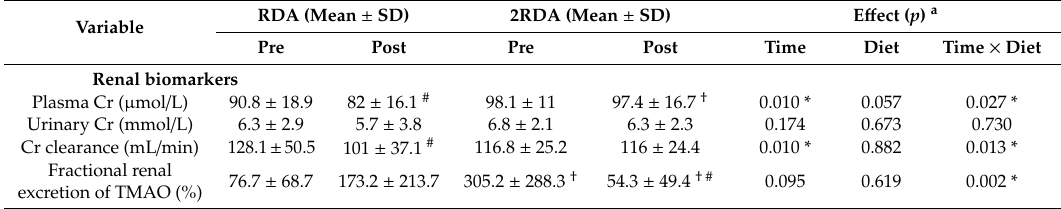
Table 4. Measurements of creatinine from plasma and urine, calculated creatinine clearance, and calculated fractional renal excretion of TMAO of the RDA and 2RDA groups pre- and post- intervention .